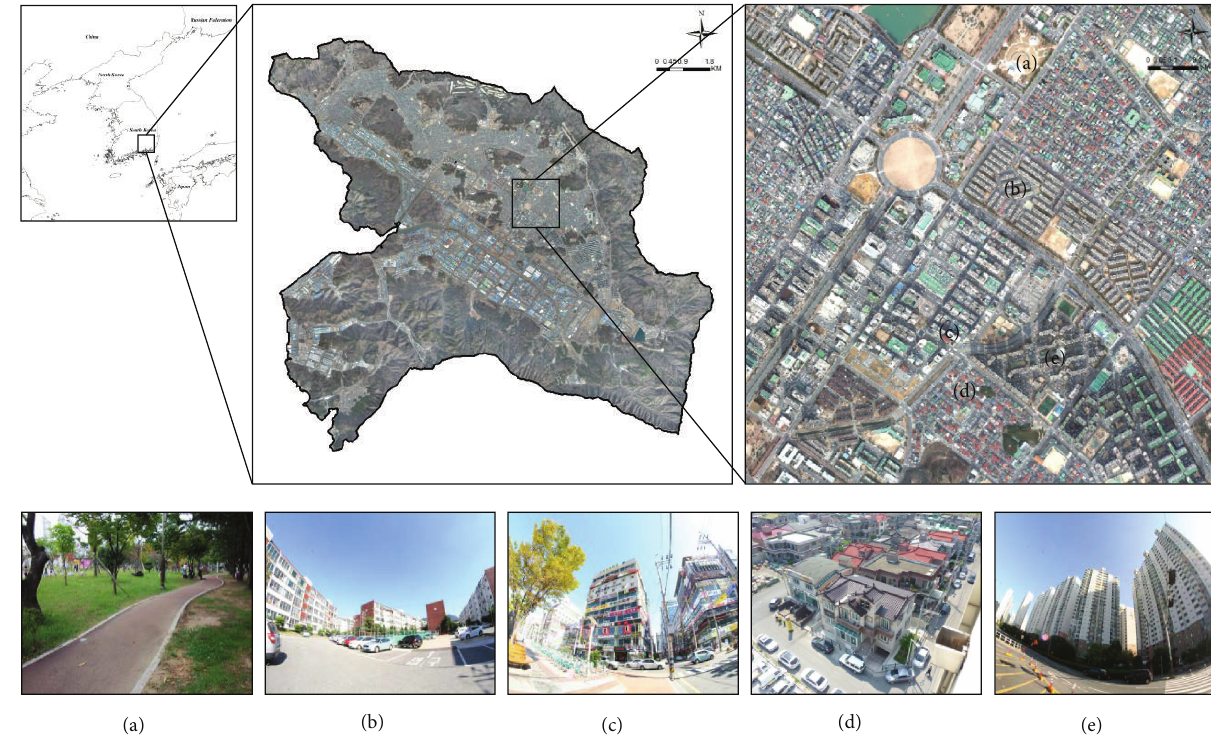
Figure 1: Five analysis areas encompassing different urban landscapes and land-use types in Changwon City, namely, (a) an urban park, (b) a low-rise apartment area, (c) a commercial area, (d) a single residential area, and (e) a high-rise apartment